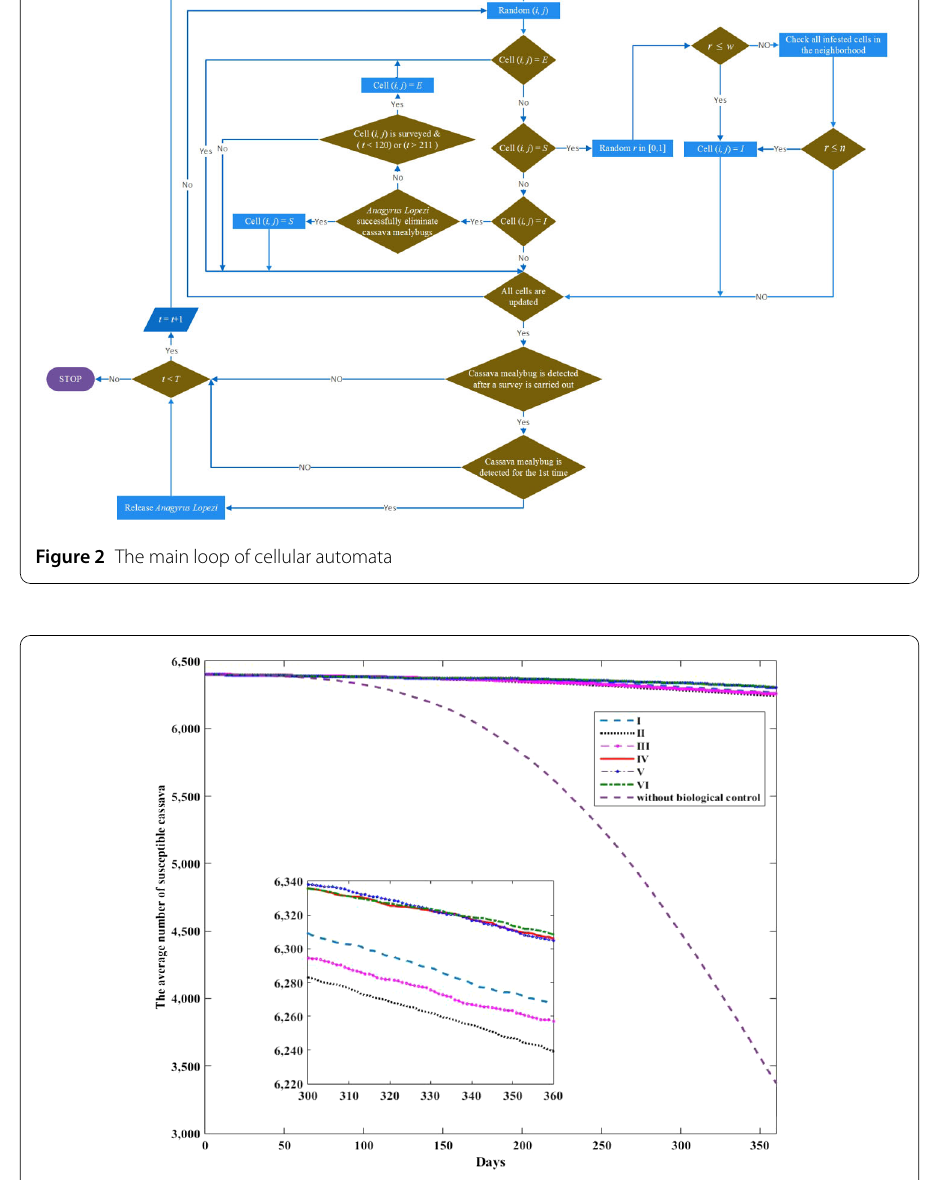
Figure 3 The average number of susceptible cassava